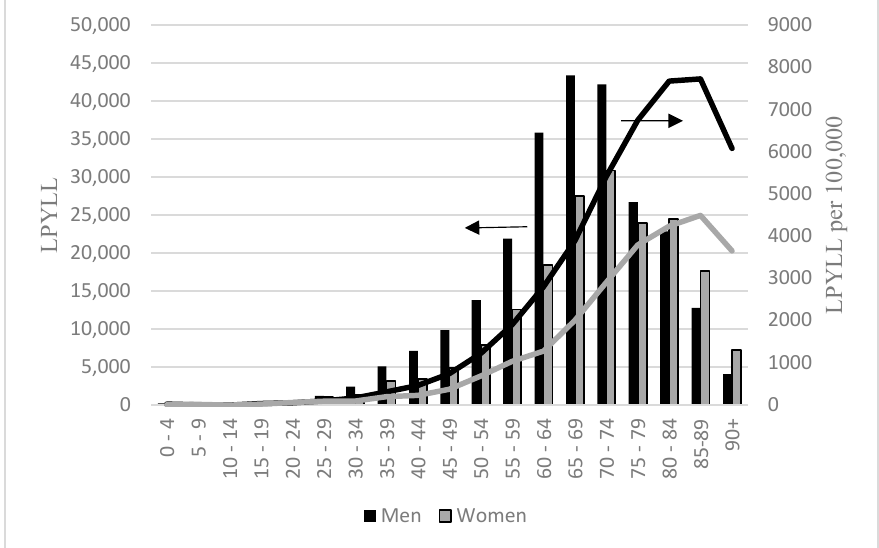
Figure 1. Country-specific (local) potential years of life lost (LPYLL) among people with COVID-19 in Poland in 2020 by age and sex. LPYLL—scale on the left, columns; LPYLL per 100,000—scale on the right, lines.